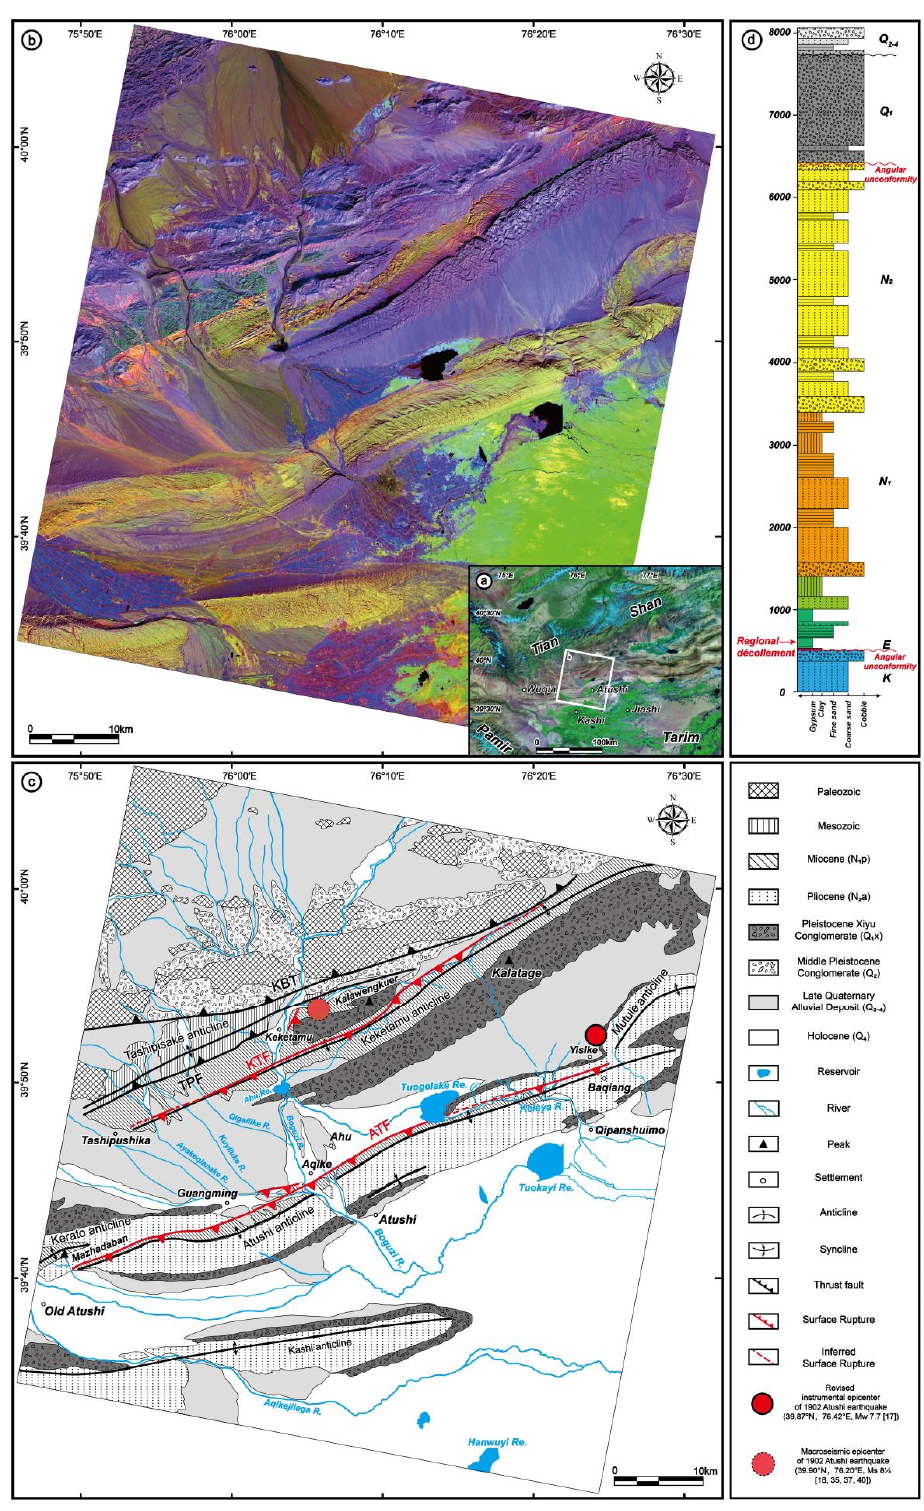
Figure 1. ( a ) A Landsat ETM/TM mosaic image of the Pamir-Tian Shan convergence zone, white polygon shows the location of the AFTB. ( b ) ASTER false color composite image of 2/1(R), 3(G) and 5/8(B) of AFTB; ( c ) geological interpretation of AFTB showing that there are 3–4 rows of sub-parallel active fault-related folds. Stratigraphic and tectonic data are modified from [11,12,48,50,54]. Seismic data are from [17,18,35,37,40]; ( d ) summary of AFTB stratigraphic columnar profile from Cretaceous to Quaternary, according to